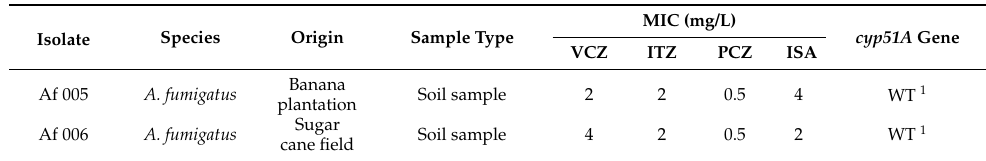
Table 3. Characteristics in vitro antifungal susceptibility profiles of azole-resistant Aspergillus spp. isolates ( n = 2) from environmental